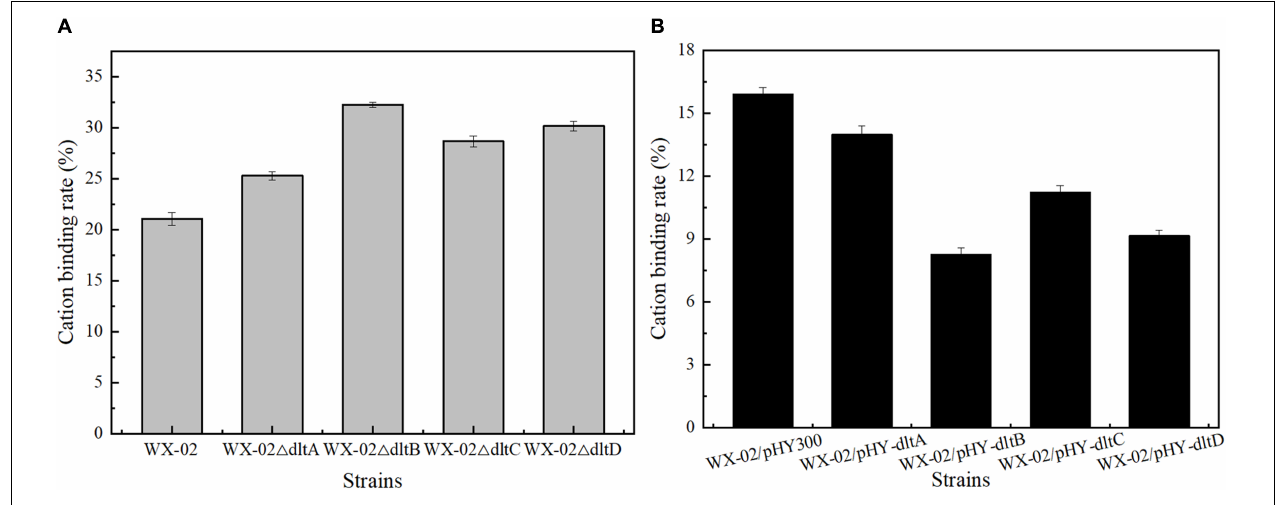
FIGURE 2 | Effects of deletion and overexpression of dlt operon on the cation binding rate. (A) The cation binding rates of WX-02, WX-02 (cid:49) dltA , WX-02 (cid:49) dltB , WX-02 (cid:49) dltC , and WX-02 (cid:49) dltD . (B) The cation binding rates of WX-02/pHY300, WX-02/pHY- dltA , WX-02/pHY- dltB , WX-02/pHY- dltC , and WX-02/pHY- dltD .